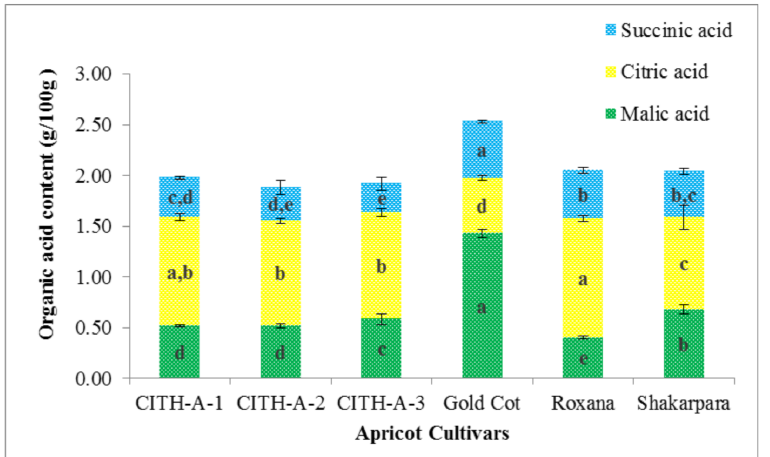
Figure 3. Organic acids content of apricot genotypes from India. The same letter (a, b, c, or d) inside a similarly coloured block indicates no statistically significant differences in values ( p <